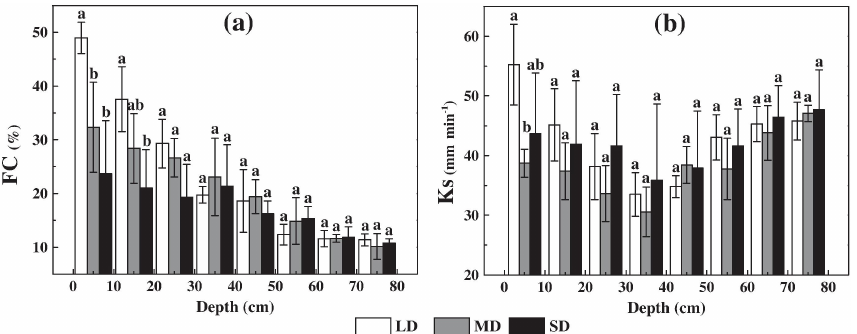
Figure 6. Differences in field capacity (FC) and saturated hydraulic conductivity ( K s ) with degradation degree. Error bars denote the standard deviation of the three sites of the same degradation degree. Bars with the same letter indicate that no significant differences ( p < 0.05) exist between corresponding degradation degrees. LD: lightly degraded, MD: moderately degraded, SD: severely degraded.